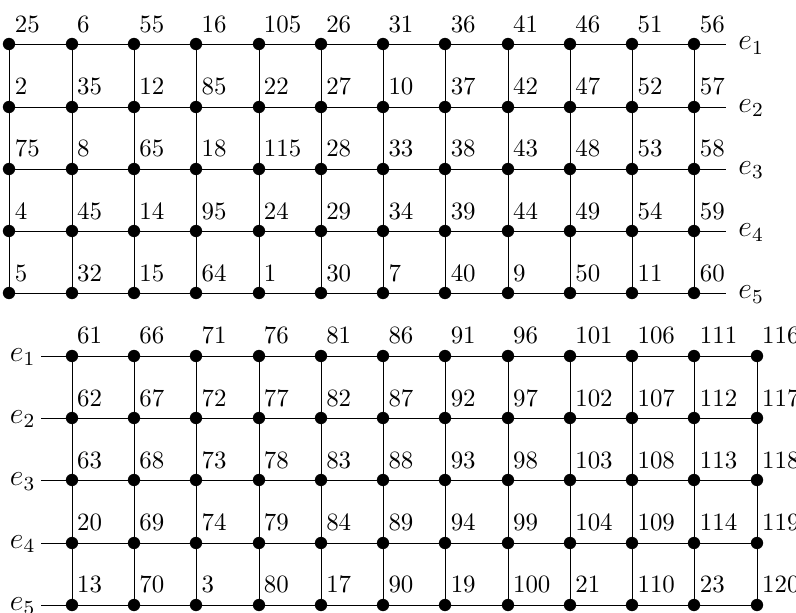
Figure 4: Prime labeling on P